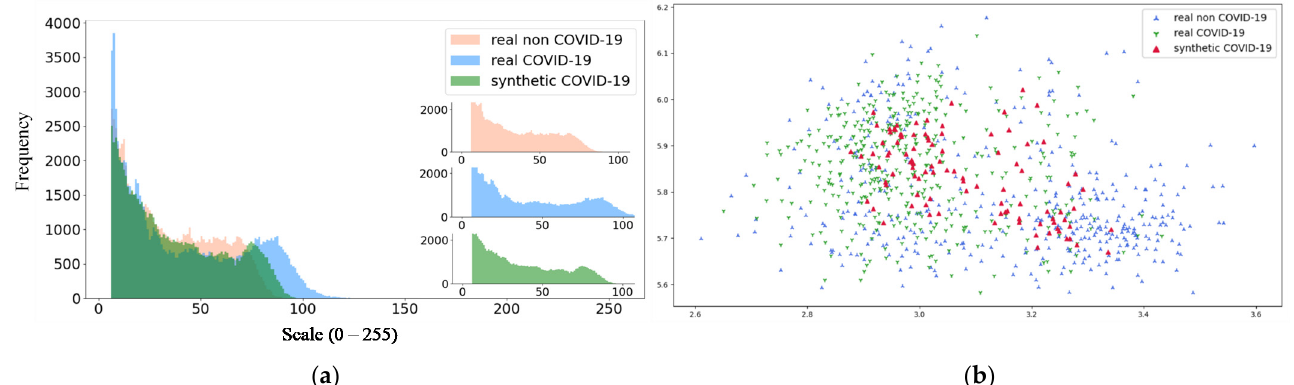
Figure 17. ( a ) Pixel distribution and ( b ) UMAP scatter plot of real COVID-19 real non-COVID-19, and synthetic COVID-19 CT images.